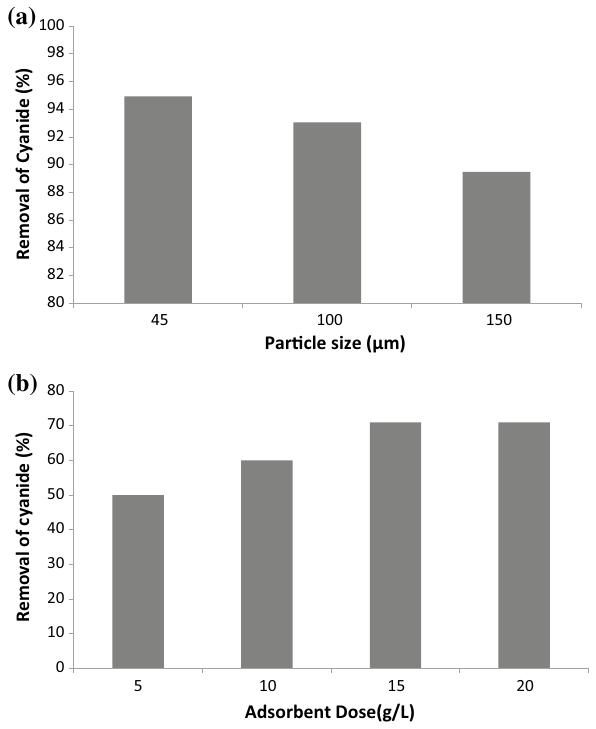
Fig. 4 a Effect of different particle size on removal of cyanide. b Effect of different adsorbent dose on removal of cyanide